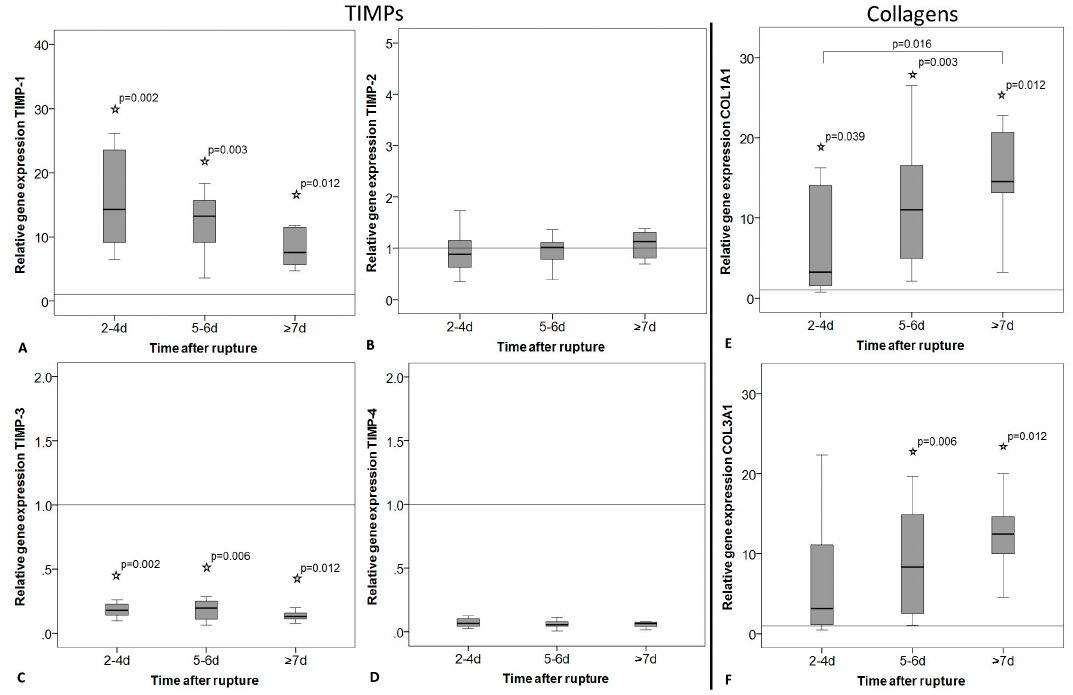
Figure 4. Relative gene expression of tissue inhibitors of metalloproteinases (TIMPs) and collagens in intact tendon tissue (horizontal line, value = 1) and in tendon tissue of early (2–4 d), middle (5–6 d), and late ( ≥ 7 d) time after rupture. Measures of qRT-PCR were normalized to the expression of the house keeping gene 18S-rRNA using the Δ Ct method with efficiency correction, given as fold change to the intact group (horizontal line, value = 1), and represented as box plot graphs. Significant differences to the intact group are marked with a star and time-related differences with a spanning line. ( A ) TIMP-1 expression was significantly lower, whereas ( C ) TIMP-3 expression was significantly higher in the intact compared to the ruptured tendons. ( A – D ) In general, TIMP expression did not change significantly over time. ( E ) COL1A1 and (F ) COL3A1 expression was significantly increased in ruptured tendons compared to intact tendons. COL1A1 expression significantly increased with the time after rupture from the early to the late time point group.